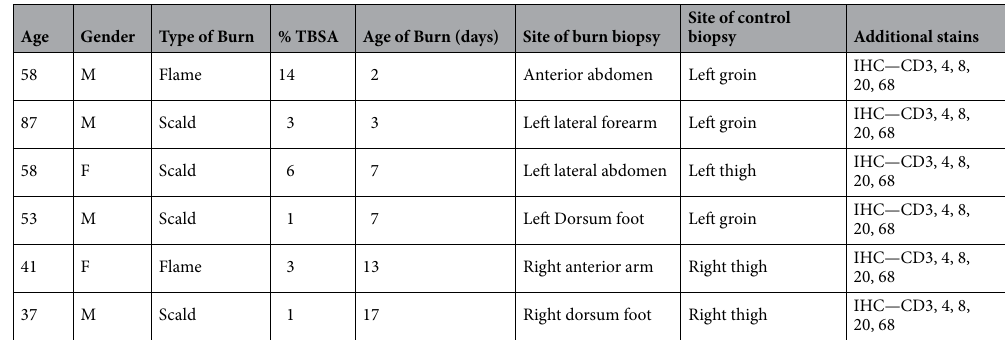
Age Gender Type of Burn % TBSA Age of Burn (days) Site of burn